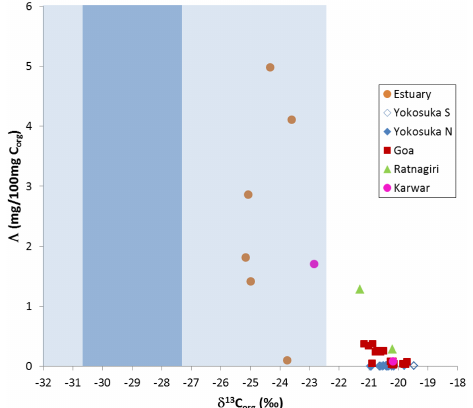
Figure 5. Plot for surficial sediments of total lignin phenol yield ( (cid:51) ,mg100mg − 1 C org ) against stable C isotopic composition ( δ 13 C org ) . Shaded areas indicate the range of δ 13 C org values found in upriver SPM samples (darker shading, this study) and across the Mandovi and Zuari estuaries (previous studies; see